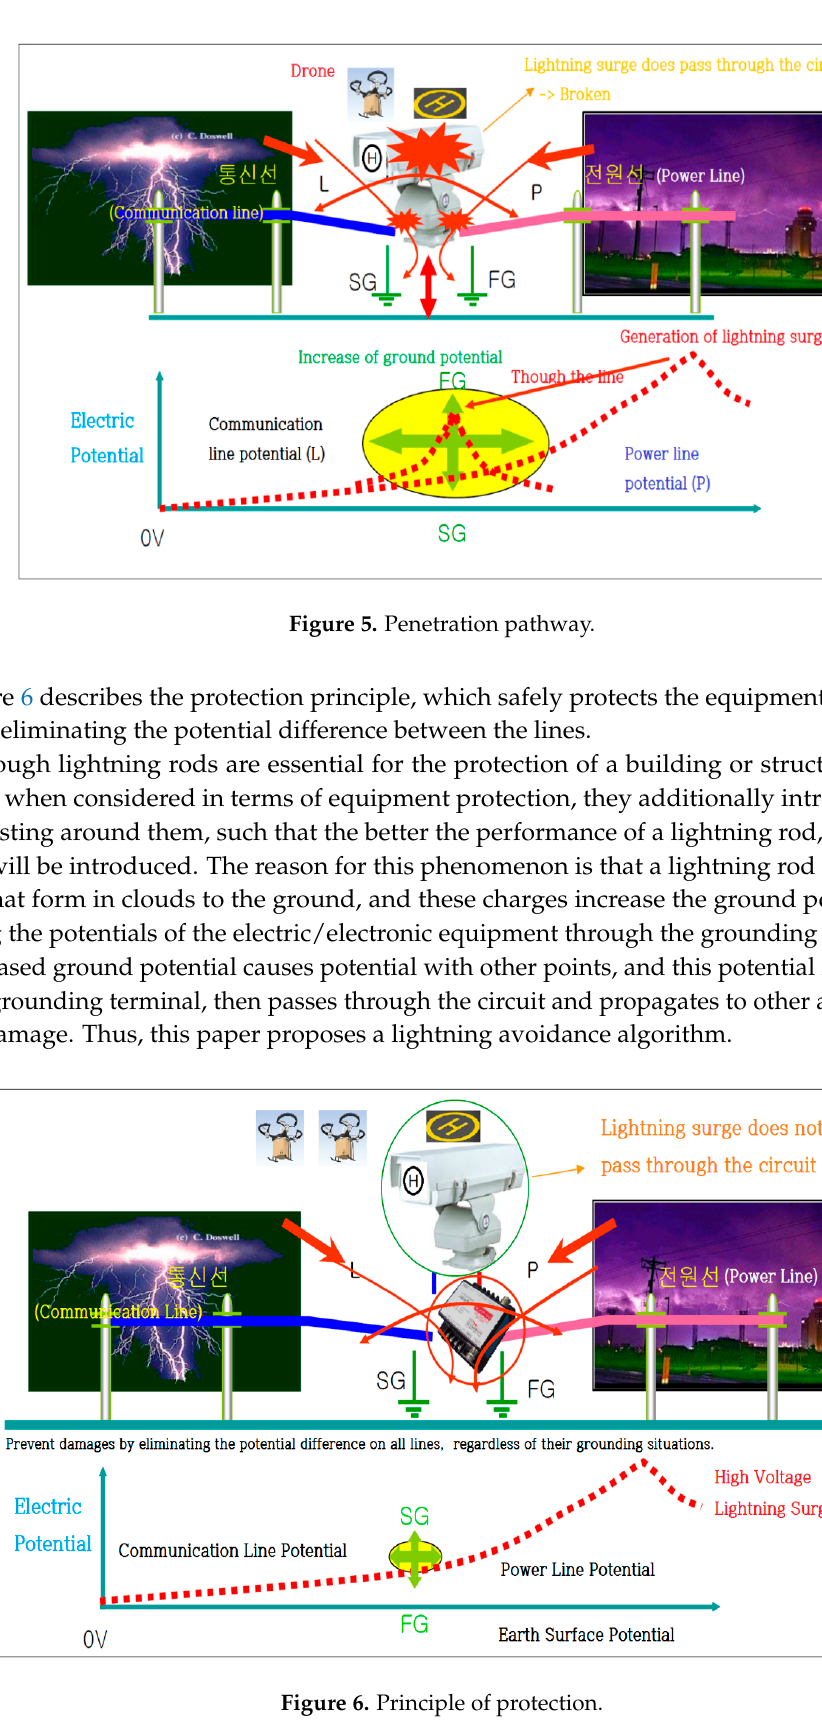
Figure 4. Path of lightning and cause of damage.